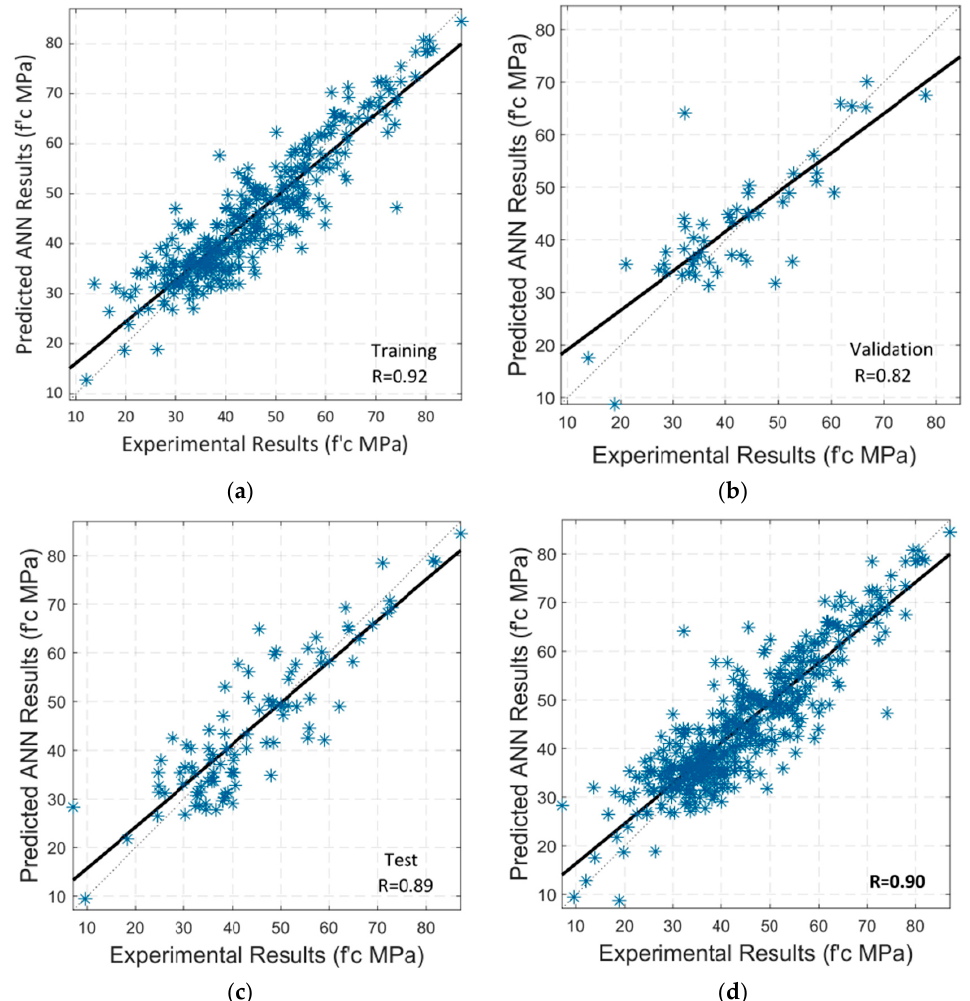
Figure 11. Regression analysis by using LM algorithm between experimental and predicted com- pressive strength: ( a ) Training; ( b ) Validation; ( c ) Testing; ( d ) Overall Dataset.